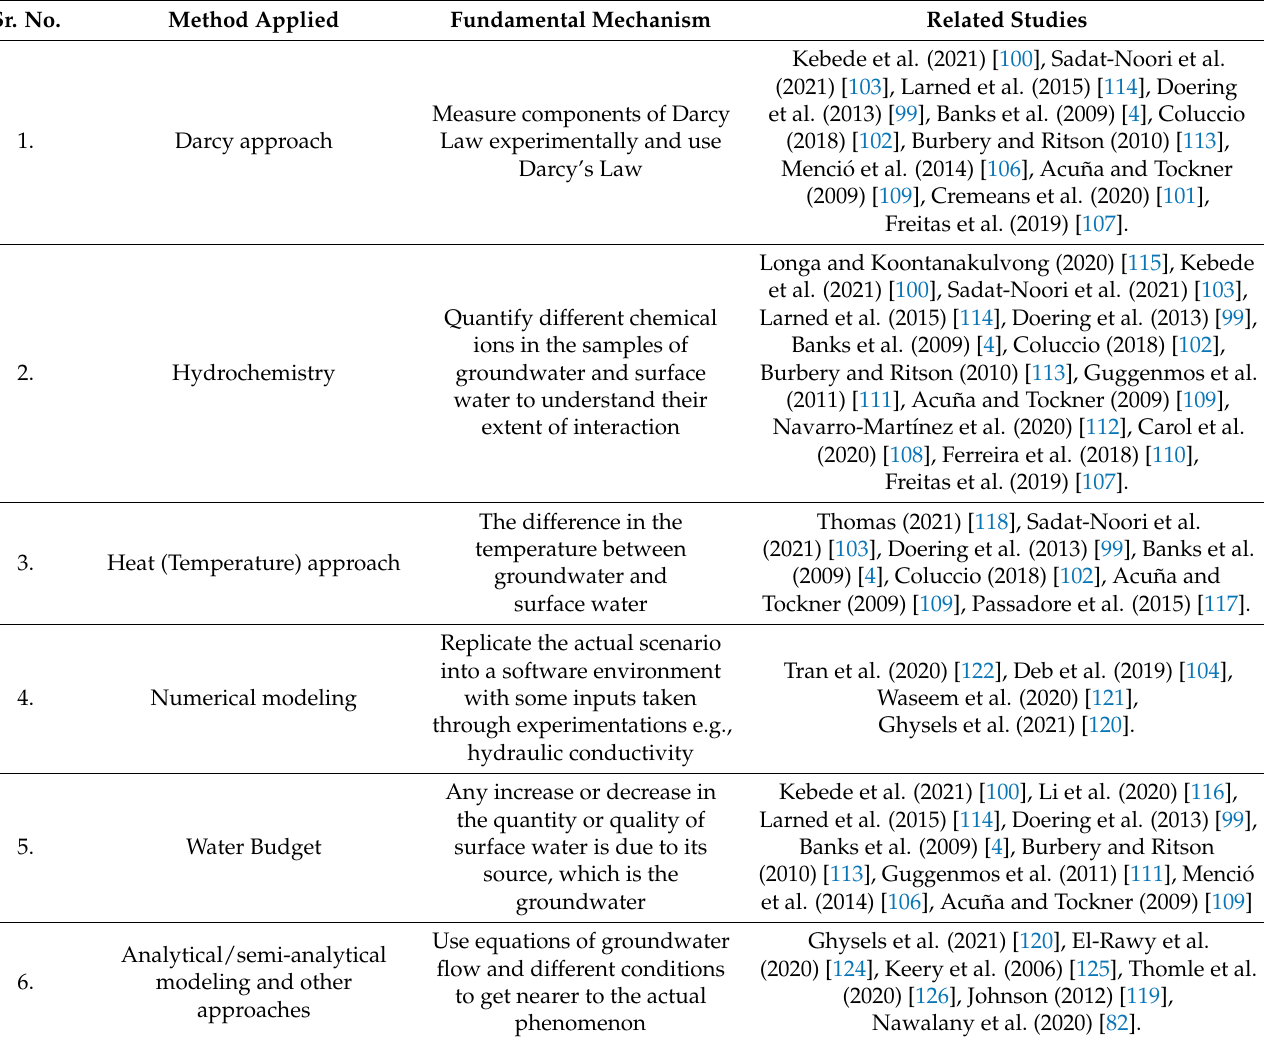
Table 2. Research works referred to, for each approach of GW–SW